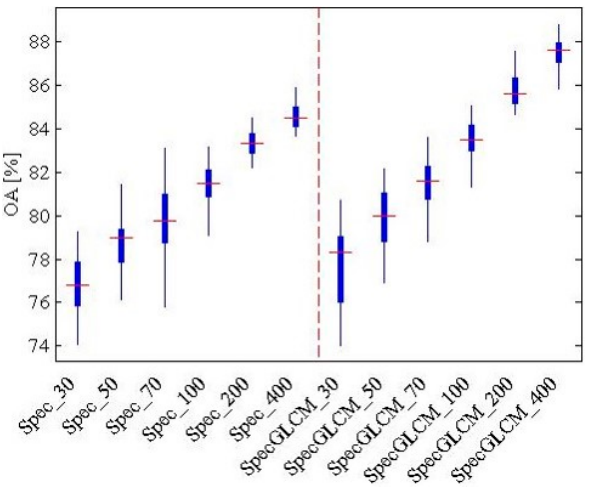
Figure 13. Wuhan IKONOS dataset: ( a ) dense residential; ( b ) idle land; ( c ) industrial; ( d ) medium residential; ( e ) parking lot; ( f ) commercial; ( g ) vegetation; and ( h ) water.